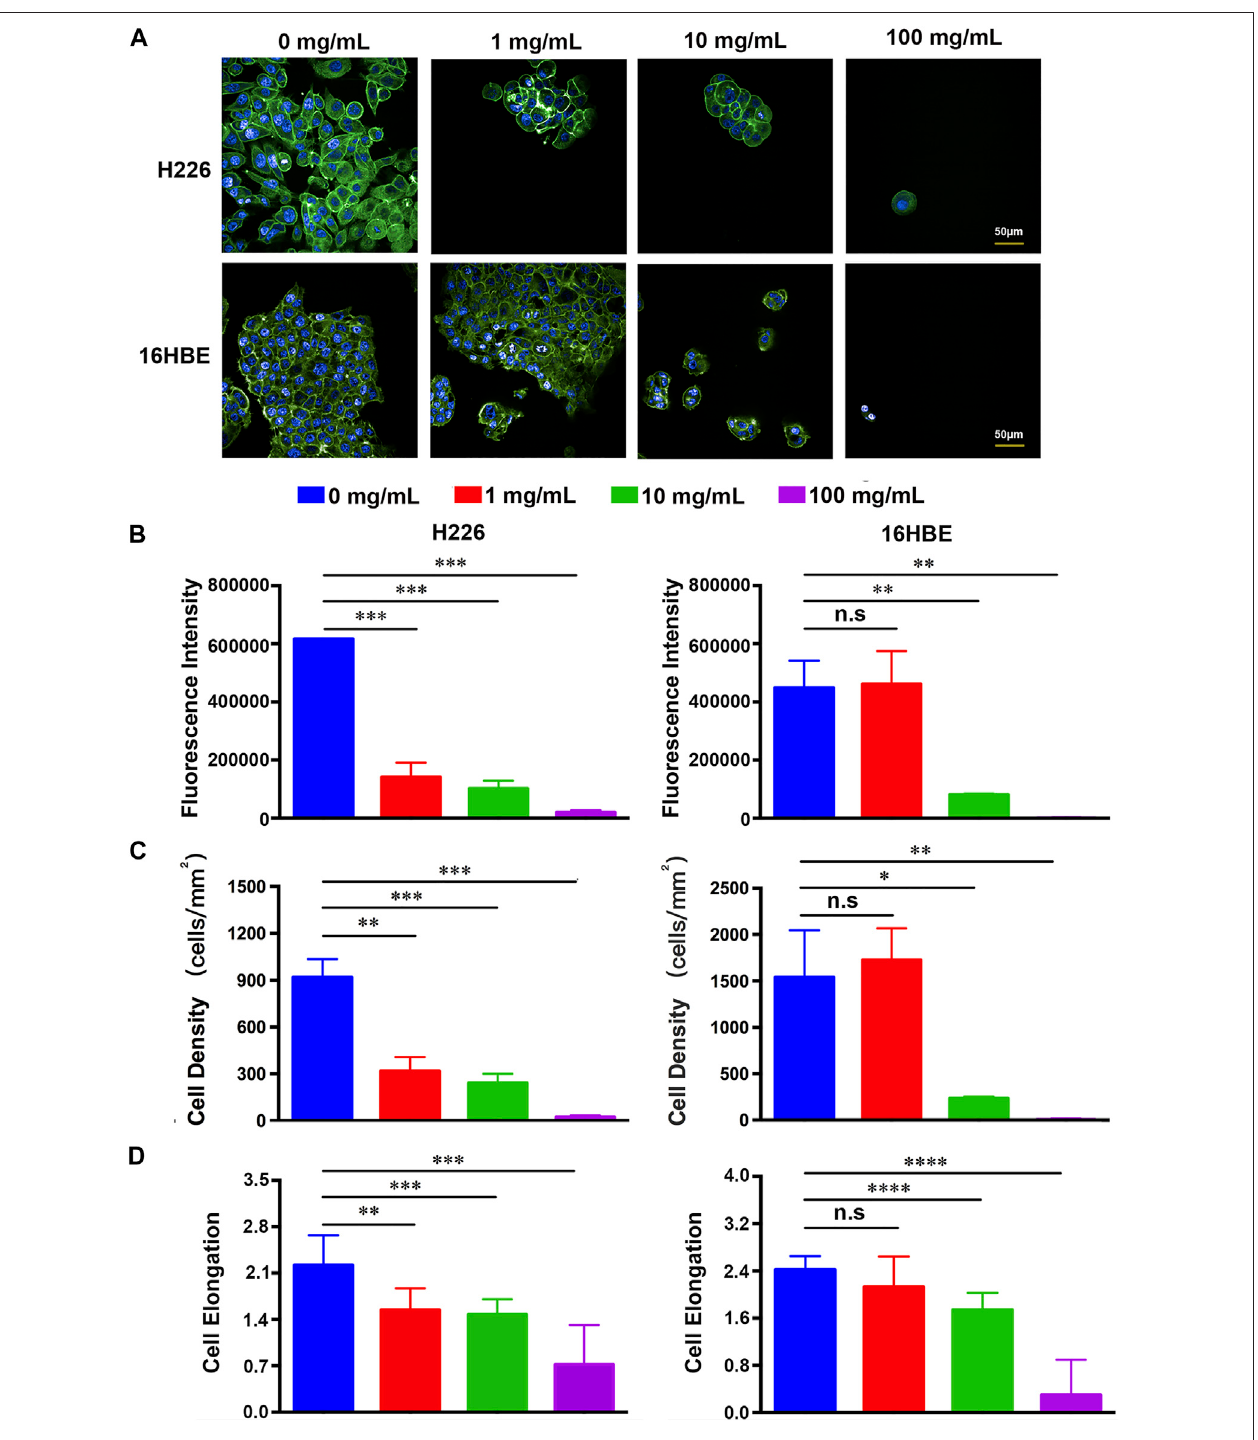
FIGURE1|(A) FluorescenceimagesofH226and16HBEcellstreatedwithdifferentconcentrationsoffucoidan. (B – D) Quantitativeresultsoftheexpression ofthe actin cytoskeleton, cell density and elongation in H226 and 16HBE.